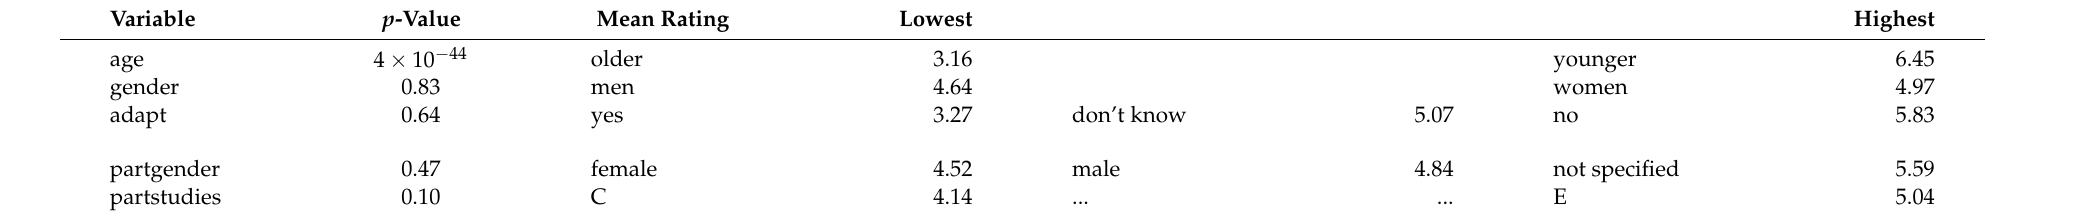
Table A7. Likelihood of use for Smartphone (SP), p -value from ANOVA with associated mean ratings.